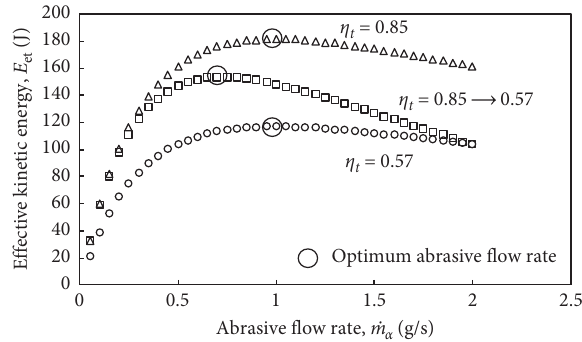
Figure 2: Effects of the momentum transfer parameter on the abrasive kinetic